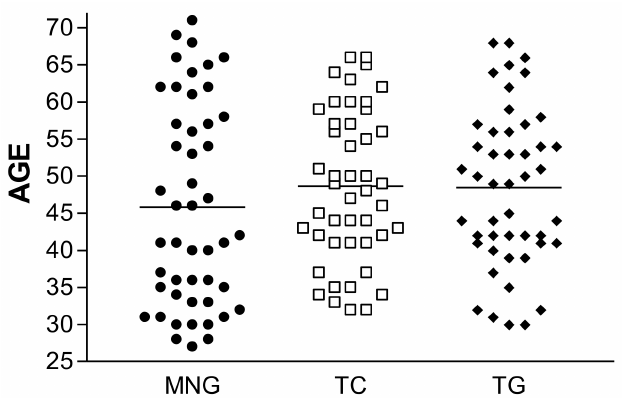
Figure 2. Age distribution and mean age for each category of disease. There was no significant difference between the groups ( p = 0.42). MNG: multinodular goiter, TC: thyroid cancer, TG: Graves’ disease or toxic (multi)nodular